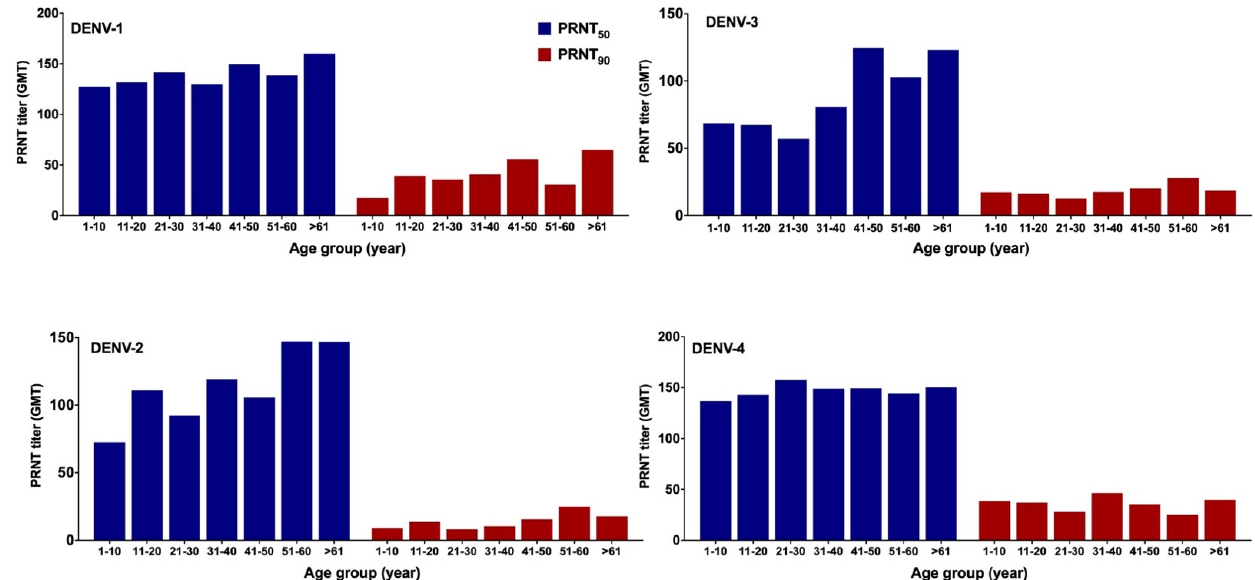
Figure 4. Stratification of geometric mean titer (GMT) of DENV neutralizing antibody (NAb) titers by age ( n = 199). DENV NAb GMTs for each age group for all serotypes were calculated based on two thresholds PRNT 50 (blue), and PRNT 90 (red).